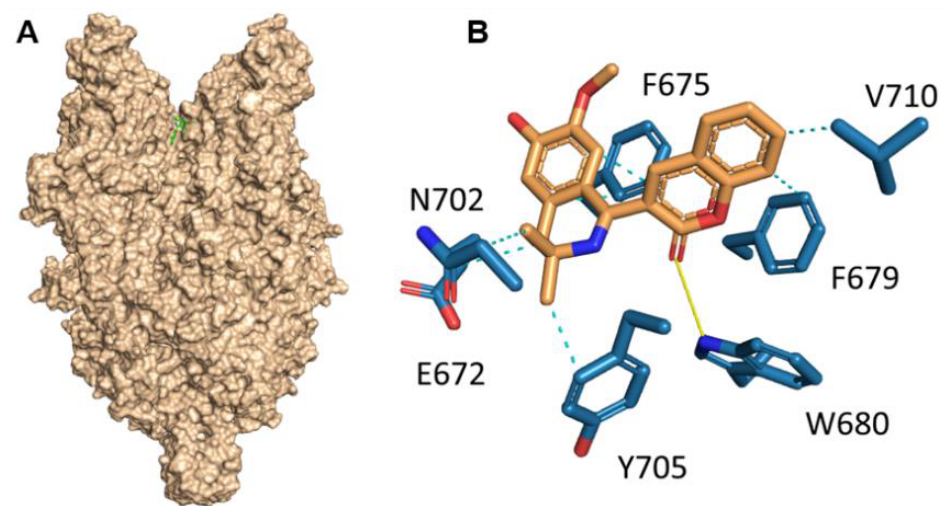
Figure 1. Position of compound C20 in the agonist binding site of TRPC6 receptor predicted by molecular docking. ( A ) Structure of TRPC6 receptor presented as molecular surface, compound C20 in green. ( B ) The main interaction of compound C20 with the binding site. The H-bond is represented by the yellow line, hydrophobic interaction by cyan dashed lines.